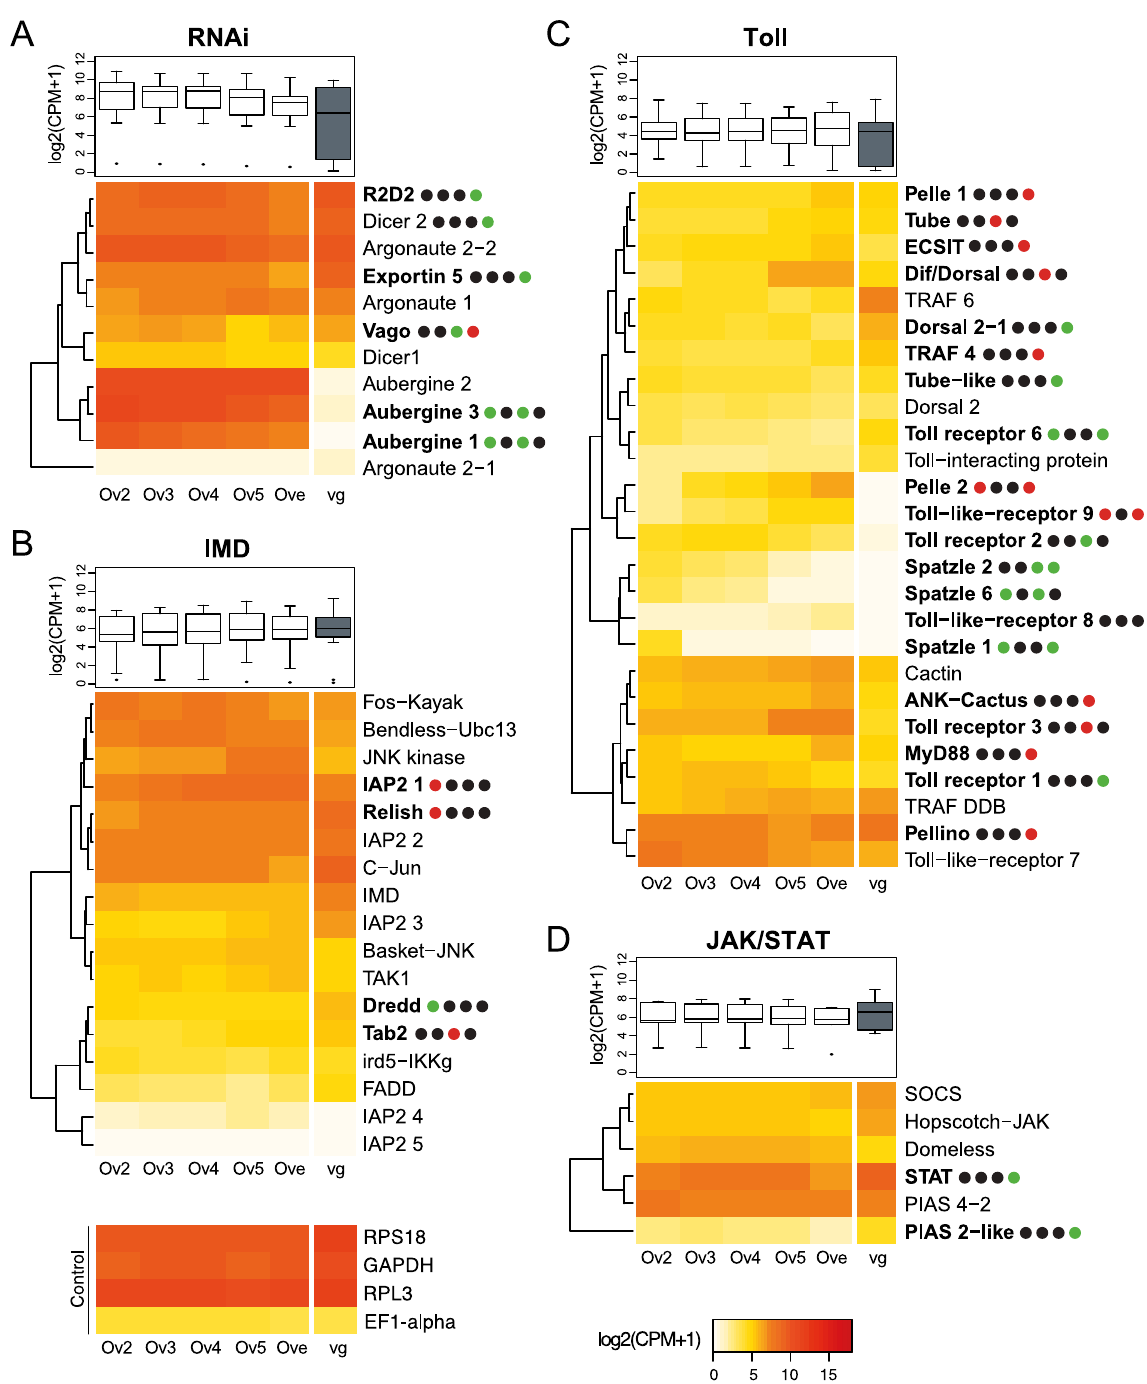
Fig. 6 Gene expression of antiviral immune genes in the ovaries during C. congregata nymphal development. The heatmaps show the expression of genes involved in A RNAi, B Imd, C Toll and D Jak-STAT pathways across the developmental stages of ovaries (Ov2, Ov3, Ov4, Ov5, Ove) and in venom glands (vg). The trees on the left are unsupervised hierarchical clustering of expression values. Boxplots represent overall expression of each pathway in ovaries and venom glands. Bold names highlight the genes that are differentially expressed between two stages and dots represent the four different comparisons studied between consecutive ovary stages (Ov2 vs. Ov3, Ov3 vs. Ov4, Ov4 vs. Ov5 and Ov5 vs. Ove). Black, red, and green dots indicate similar, increased and reduced expressions between consecutive developmental stages, respectively. Note that no particular trend appears correlated to bracovirus particles production, which occurs massively from Ov5 onward. The expression of four stable wasp genes having high (RPS18, RPL3, GAPDH) or low expression level (EF1-alpha) is presented as control for